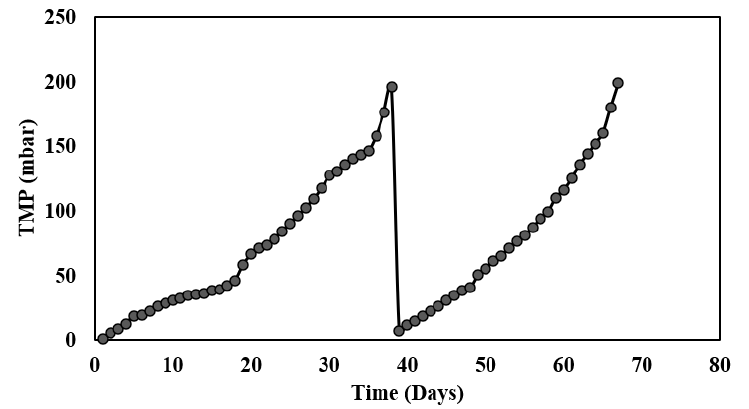
Figure 6. TMP profile of membrane during Phase